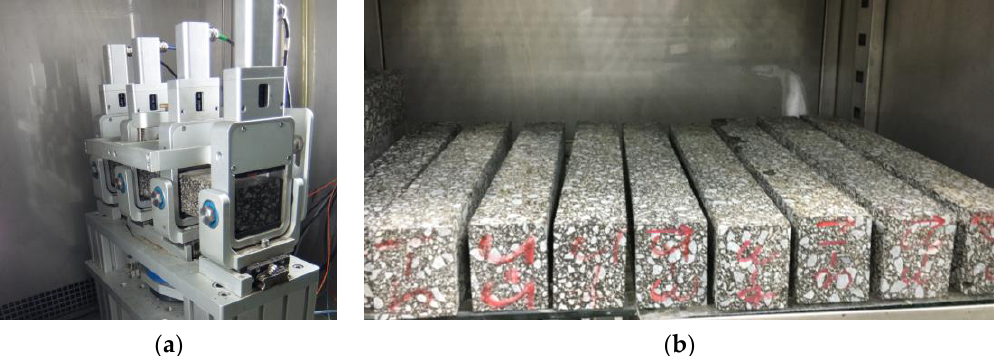
Figure 7. The test device and beam specimens: ( a ) four-point bending fatigue device and ( b ) EAC beam specimens.